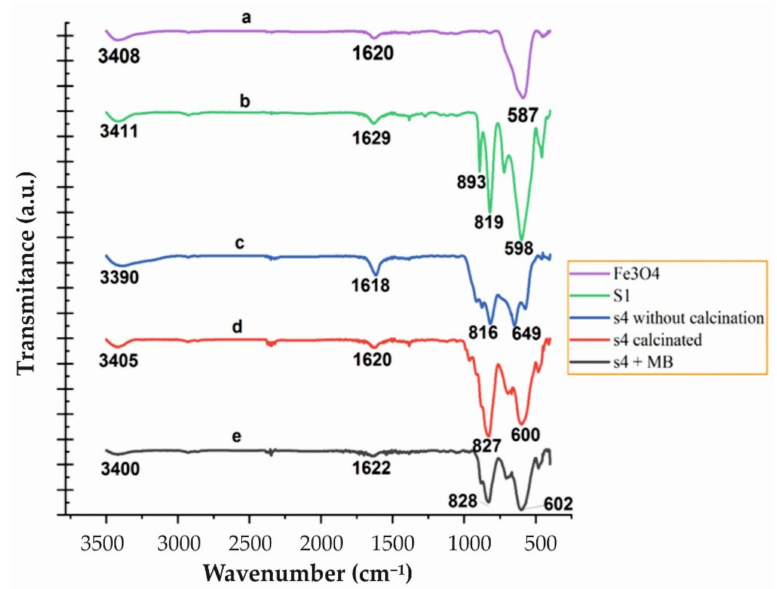
Figure 4. The FTIR spectra of ( a ) Fe 3 O 4 , ( b ) Fe 3 O 4 / CdWO 4 (S1), and ( c ) Fe 3 O 4 / CdWO 4 / PrVO 4 (S4) before calcination, ( d ) Fe 3 O 4 / CdWO 4 / PrVO 4 (S4) after calcination, and ( e ) Fe 3 O 4 / CdWO 4 / PrVO 4 (S4) after a period of MB